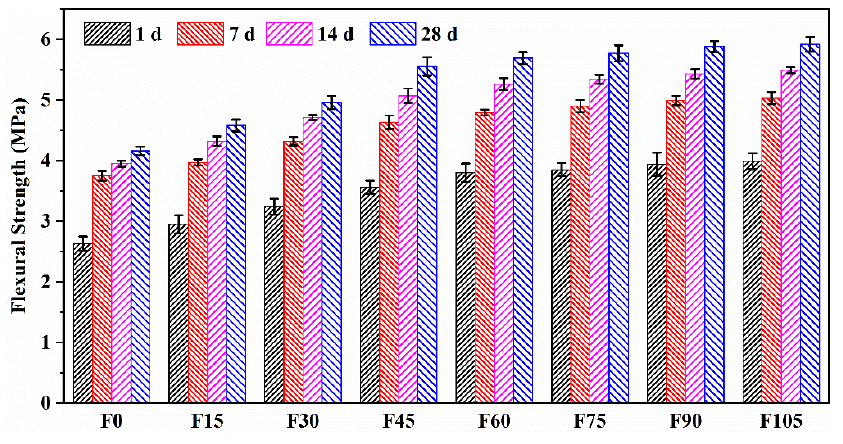
Figure 7. Flexural strengths of F0–F105.